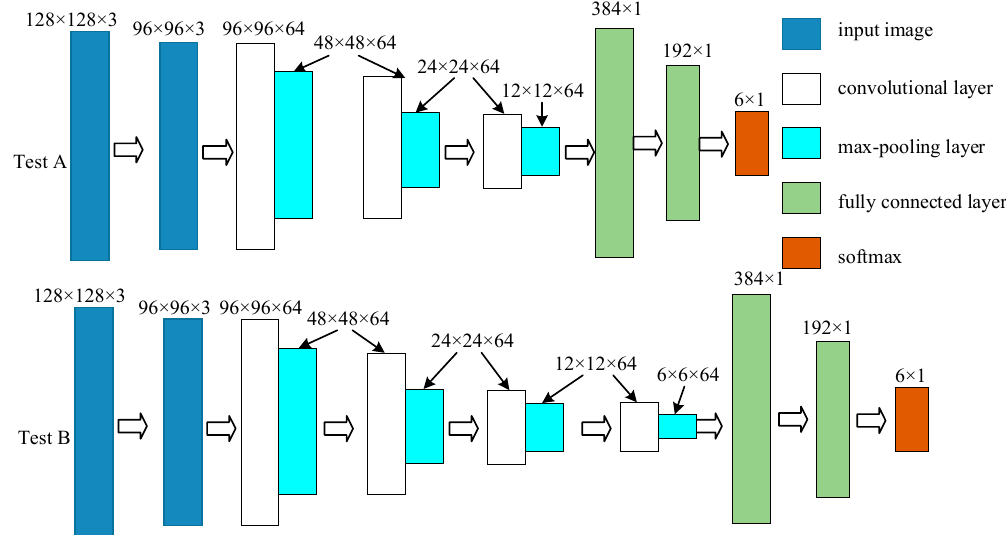
Figure 10. Schematics of two modifications to the proposed model by introducing additional layers. Test A uses one additional convolution layer and one additional pooling layer. Test B has two additional layers of each type.